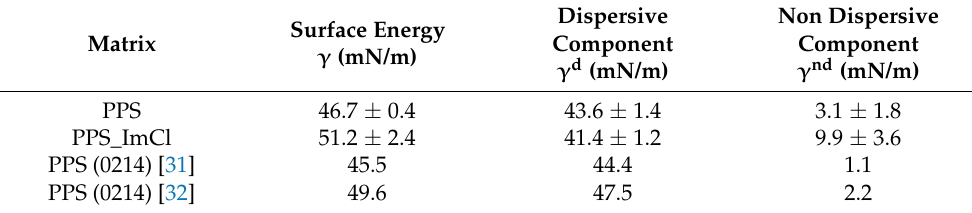
Table 4. Total, Dispersive and non-dispersive components of PPS and PPS_ImCl surface energies.